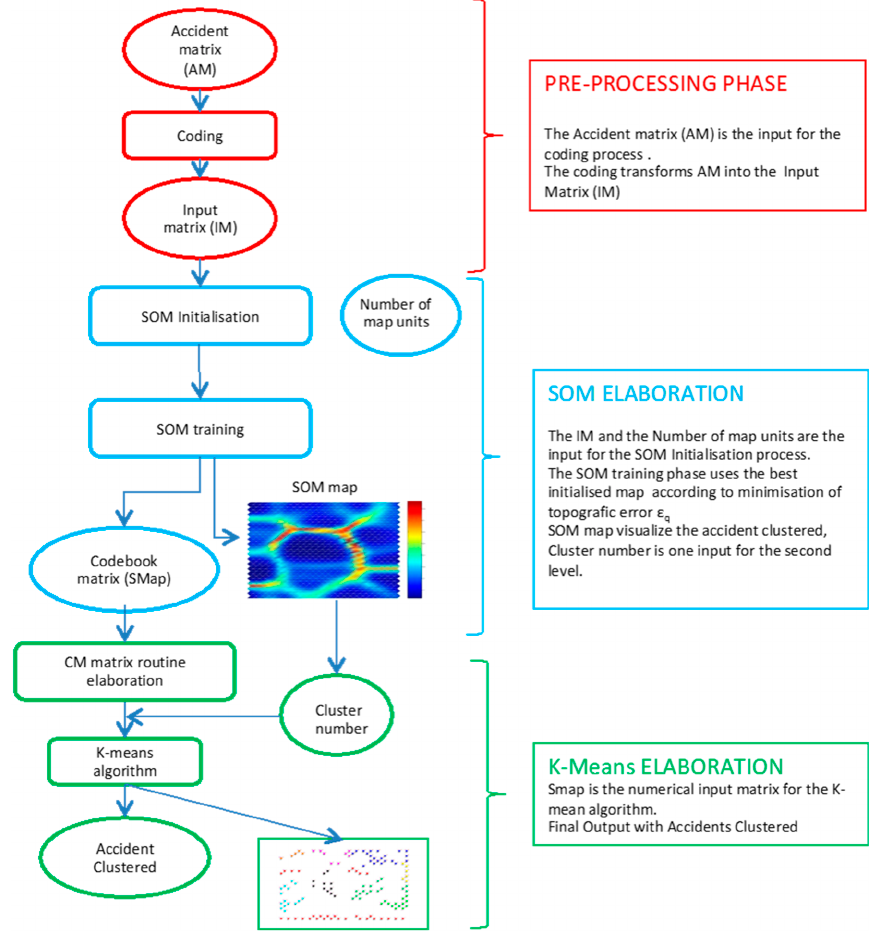
Figure 1. Self Organizing Map K-Means (SKM) scheme. Table 1. European Statistics study on Accidents at Work (ESAW) hierarchical classification, the upper and lower levels.